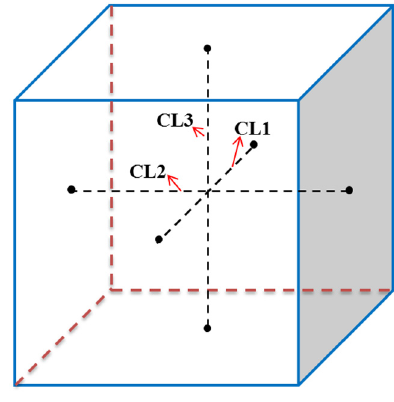
Figure 14. Observed centerlines for the cavity.